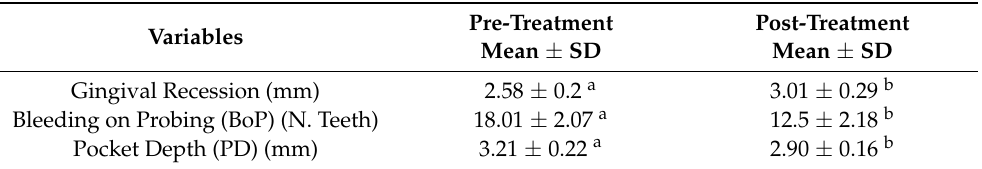
Table 2. Mean and standard deviation of the clinical assessments of periodontal patients before and after periodontal disease treatment by root planning.